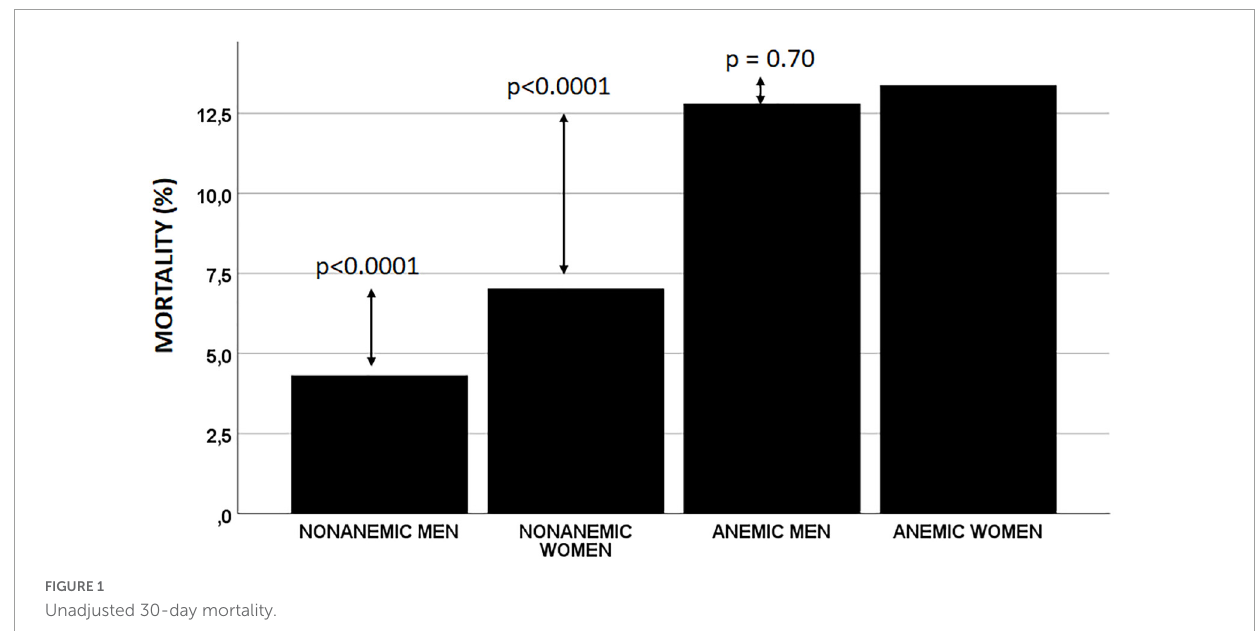
FIGURE1 Unadjusted 30-day mortality.